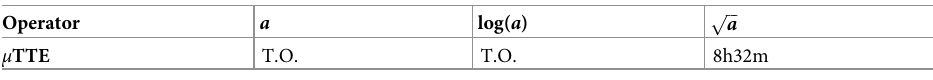
Table 4. Different factors in the performance of RLTG. Operator a log( a ) μ TTE T.O. T.O. 8h32m T.O. means that within 12 hours, the fuzzer could not reproduce the crash.